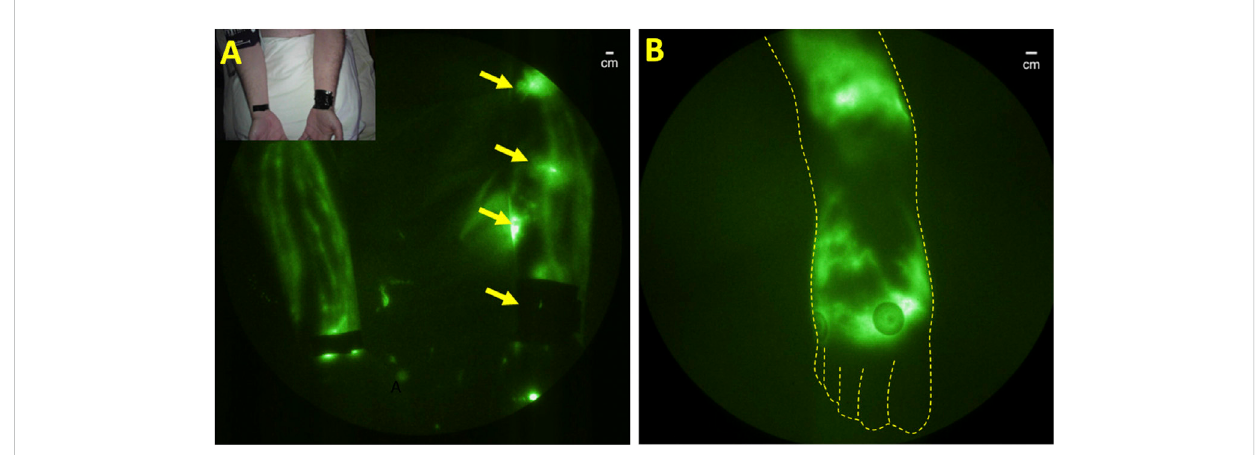
FIGURE 10 (A) Normal lymphatic drainage in the unaffected right arm and dermal back fl ow in the left arm of a subject with unresolved cutaneous Mycobacterium tuberculosis . Reproduced with permission from (Malek et al., 2021). (B) Dermal back fl ow in the foot of a patient with HIV with no other conditions that could be associated with lymphatic dysfunction.